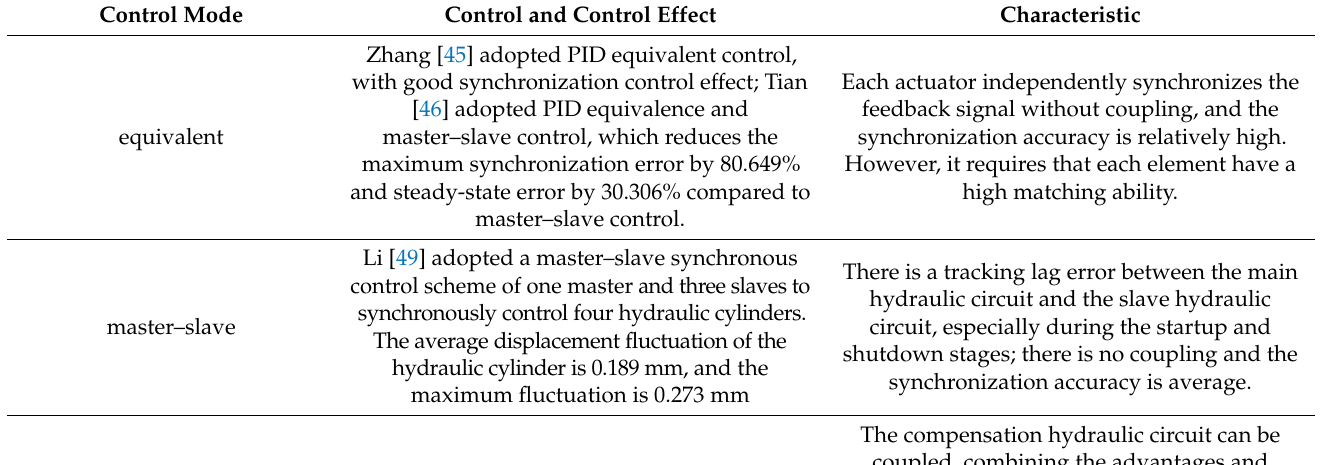
Table 1. Comparison of the effects of four control methods for closed-loop hydraulic synchronization